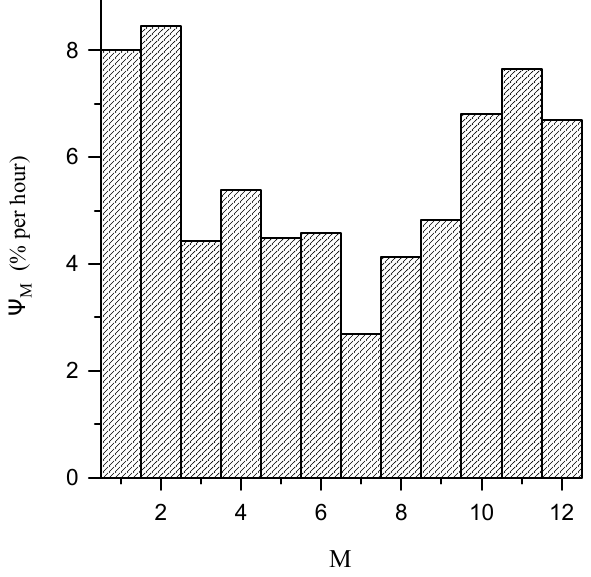
Fig. 1. The dependence of the NETE occurrence probability 9 M Fig. 1 on a number M of a given month in a